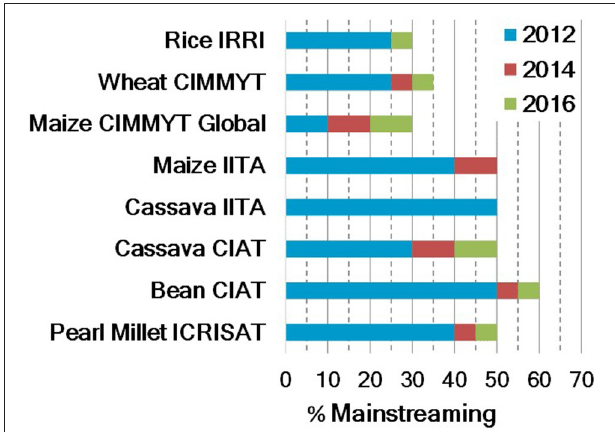
FIGURE 3 | Percentage of mainstreaming effort at Consultative Group on International Agricultural Research (CGIAR) centers until 2016 [legend: blue (2012) indicates the cumulative % attained by the end of 2012; red and green, marginal additions by 2014 and 2016,